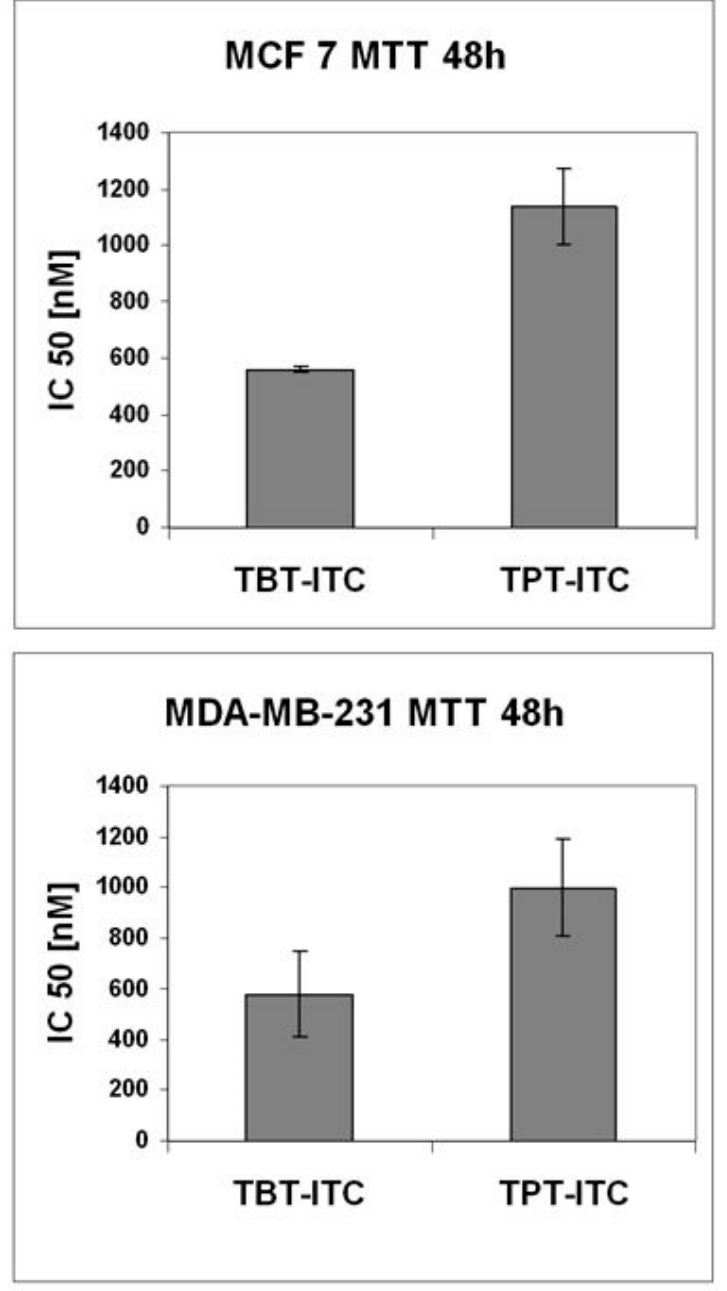
Figure 2. Cytotoxicity of tributyltin and triphenyltin isothiocyanates in MCF 7 and MDA-MB-231 cells. The concentrations of drugs that inhibited cell survival to 50% (IC50) at 48 h measured by MTT assay and determined by Calcusyn software are expressed as the means ± standard deviation (SD) of three to five independent experiments.